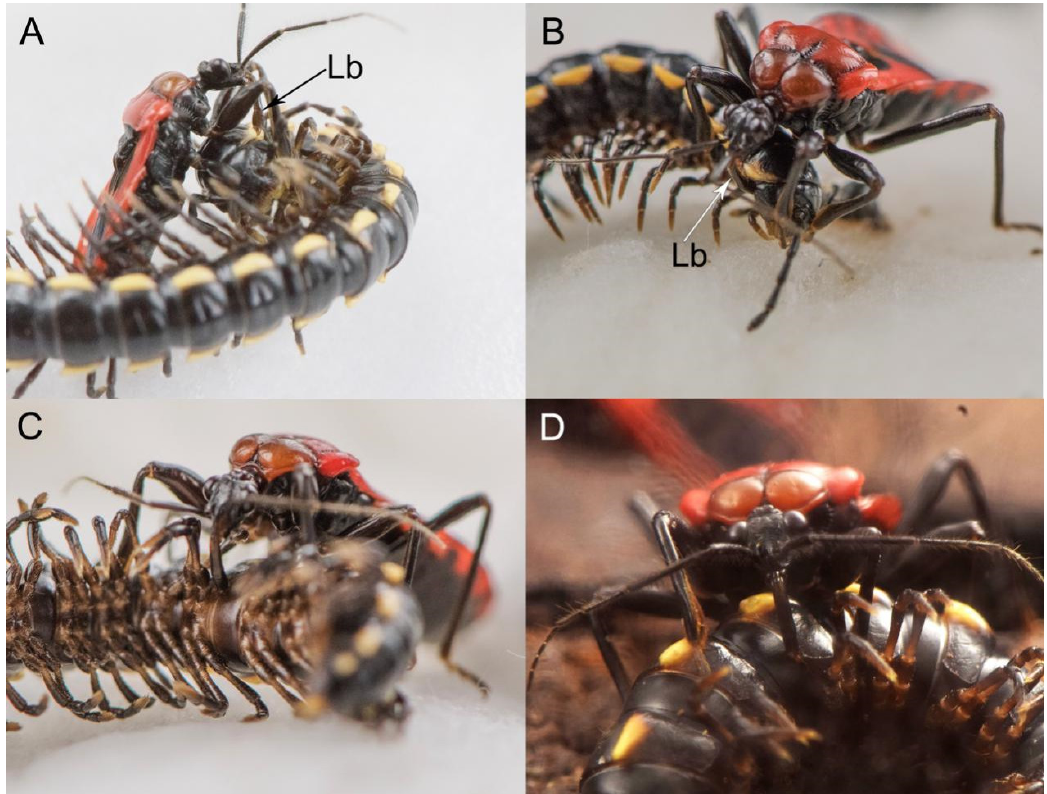
Figure 12. Feeding behavior of adult H. nigrorufa on millipede . A . Selecting an appropriate paralyzing site; B . Paralyzing millipede; C and D. Feeding on millipede; Lb, labium.